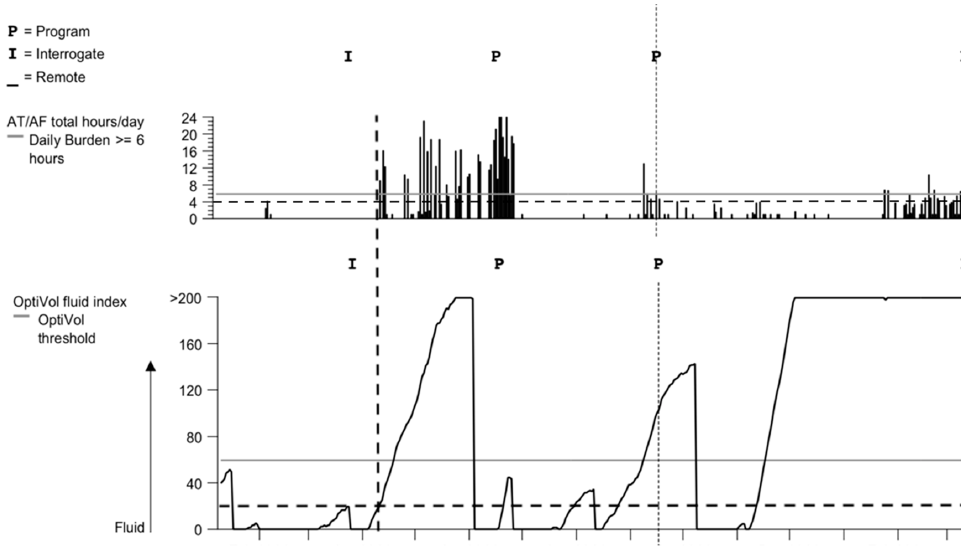
Figure 2. A representative tracing of the OptiVol fluid index (OVFI)-capable pacemaker that illustrates the AT/AF burst occurring after an OVFI increase to above the threshold of 20. AF, atrial fibrillation; AT, atrial